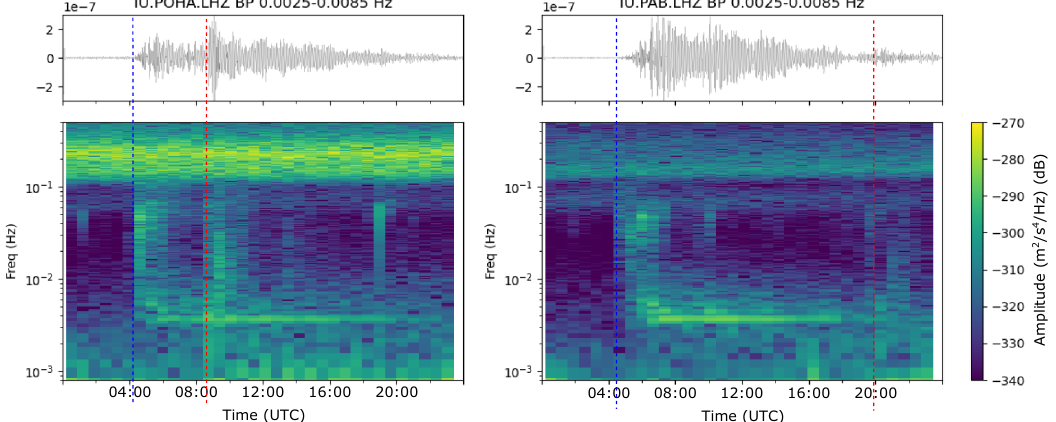
Fig. 4 Examples of the low-frequency near-monochromatic signals detected following the eruption. Seismic traces and spectrograms for two representative sites; IU.POHA station, located in Hawaii (distance: 4955 km), and IU.PAB, located in central Spain (distance: 17,730 km) km. The traces have been corrected for the instrument response and fi ltered between 2.5 and 6.5 mHz. Amplitudes are expressed in m/s. Blue dashed lines show the onset of the low-frequency signal, while red dashed lines show the arrival of the Lamb long representation of low-frequency seismic data (Fig. 3) reveal multiple passages of the Lamb wave, with stations located far from the source and its antipodal point detecting up to fi ve Lamb wave passages. To our knowledge, there are no previous observations of this kind of long-lived atmospheric-ground coupling.